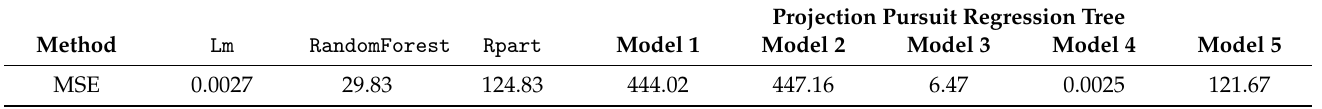
Projection Pursuit Regression Tree